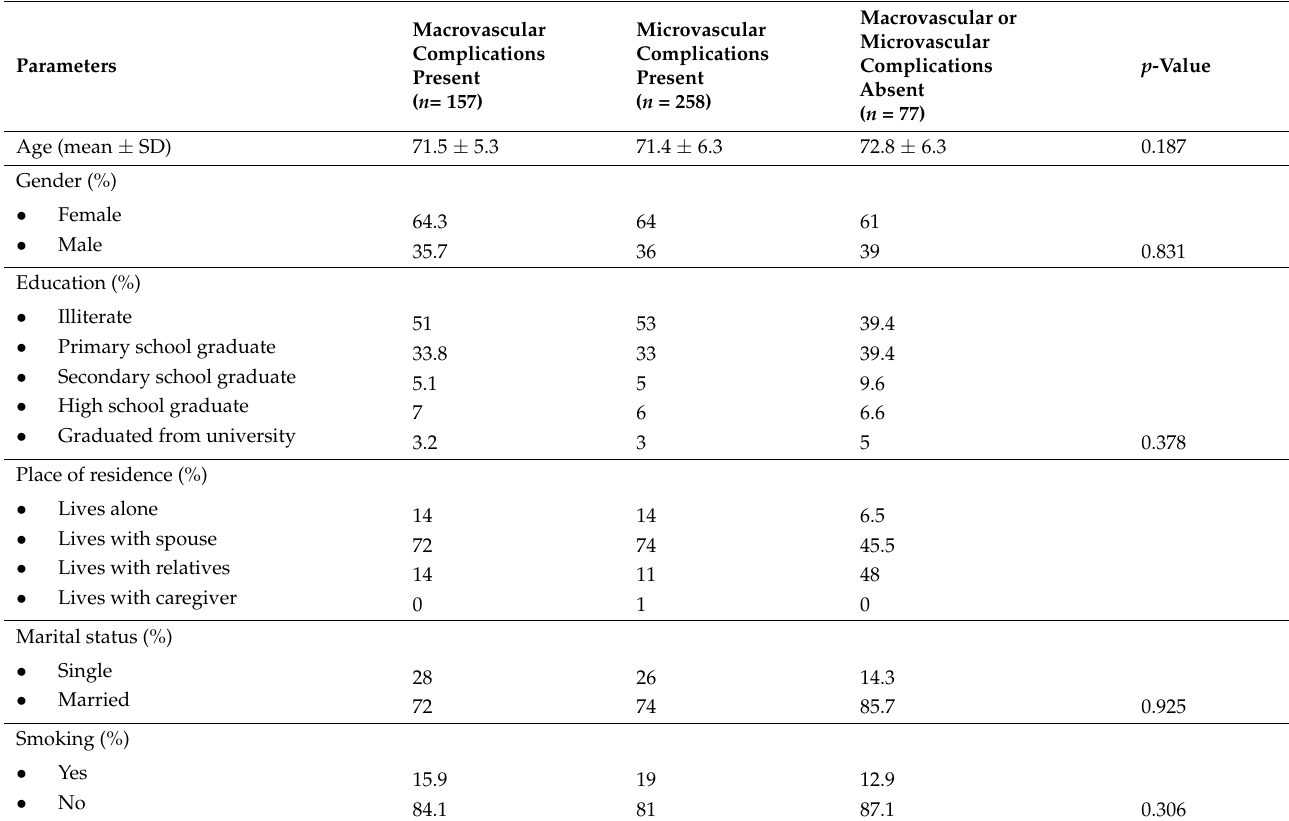
Table 1. Demographic features of the groups.